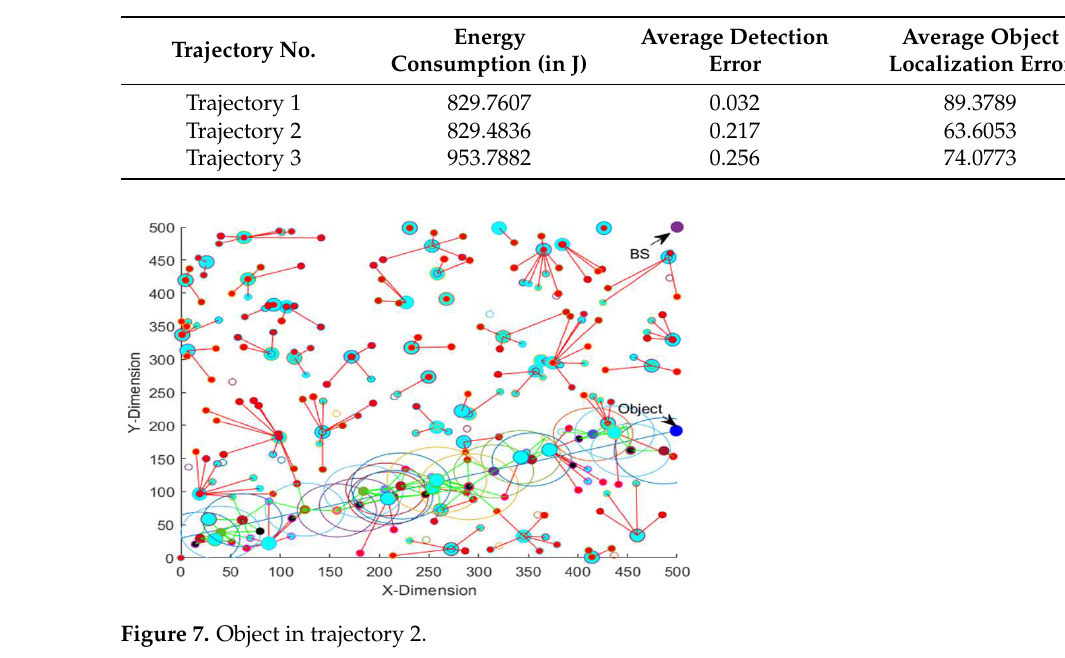
Table 12. Average object localization error and energy consumption for AOI of 500 × 500 m 2 . Table 13. Energy consumption, average detection error and average object localization error.